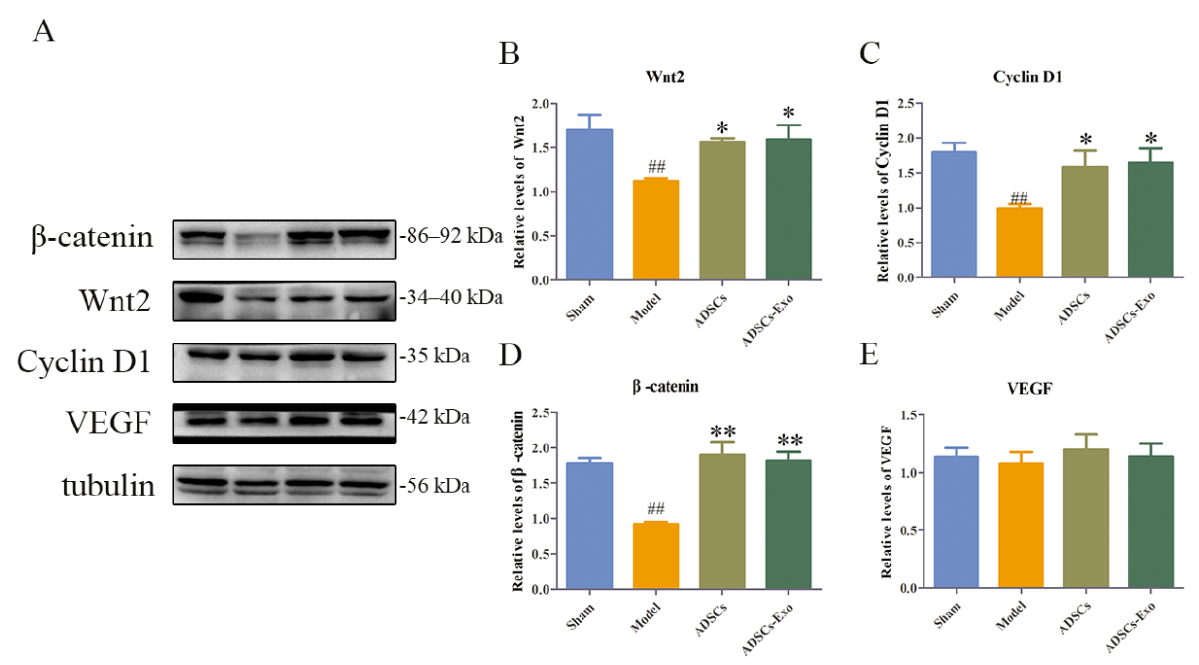
Figure 5. ADSCs-Exo increased the protein expression of regeneration in the liver. Representative Western blot analysis of Wnt2, Cyclin D1, β -catenin, and VEGF ( A ). Quantification of Wnt2, β -catenin, Cyclin D1, and VEGF ( B – E ). The data are expressed as mean ± SD. ## p < 0.01, versus the Sham group. * p < 0.05 and ** p < 0.01, versus the Model group.